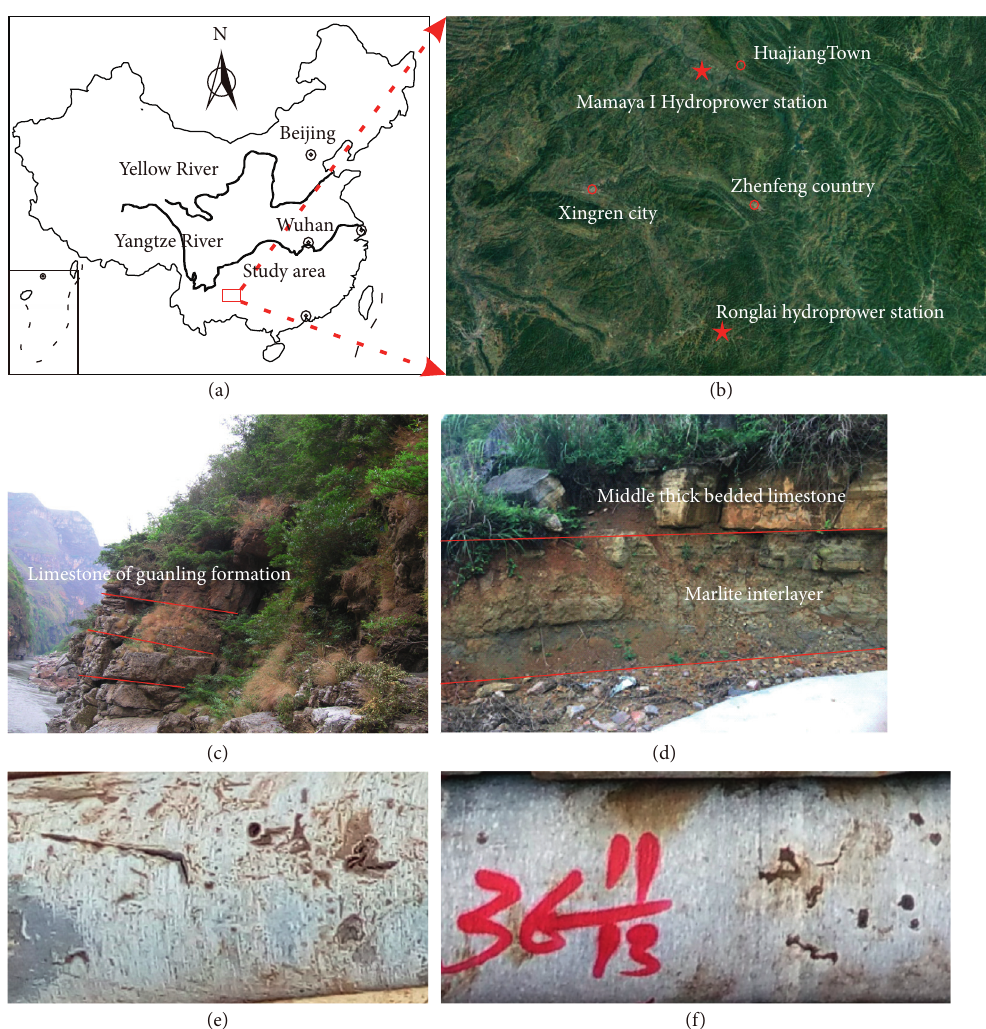
Figure 1: Sampling site and drilling core of solution pore and crevice limestone: (a) study area; (b) hydropower station location; (c) limestone in Mamaya; (d) limestone in Ronglai; (e) drilling core in Mamaya; (f) drilling core in